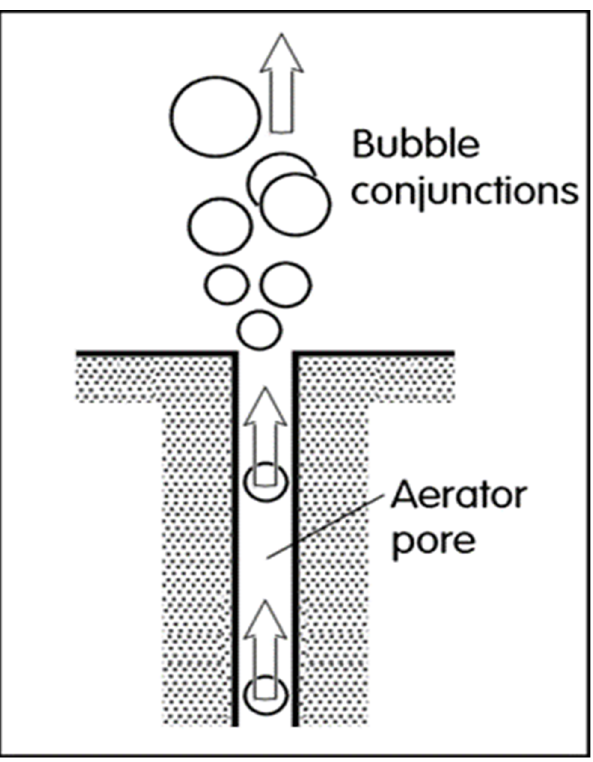
Figure 1. Representation of the conditions near the aerator pore exit with steady gas flow. The slowly moving microbubbles at the exit form larger bubbles by mutual conjunctions.